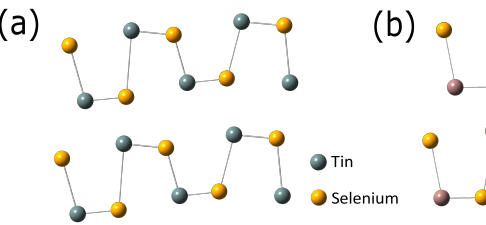
Figure 6: Crystal structure of (a) SnSe, (b) InSe, and (c)